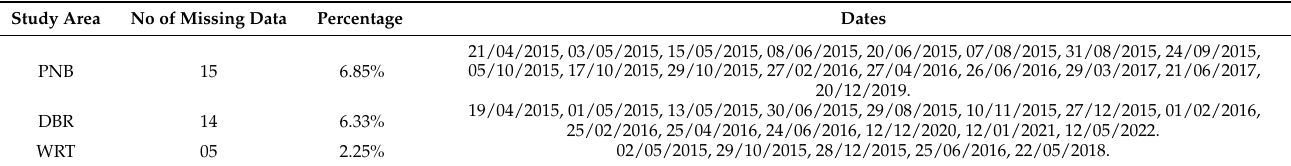
Table 6. List of dates corresponding to the missing data.